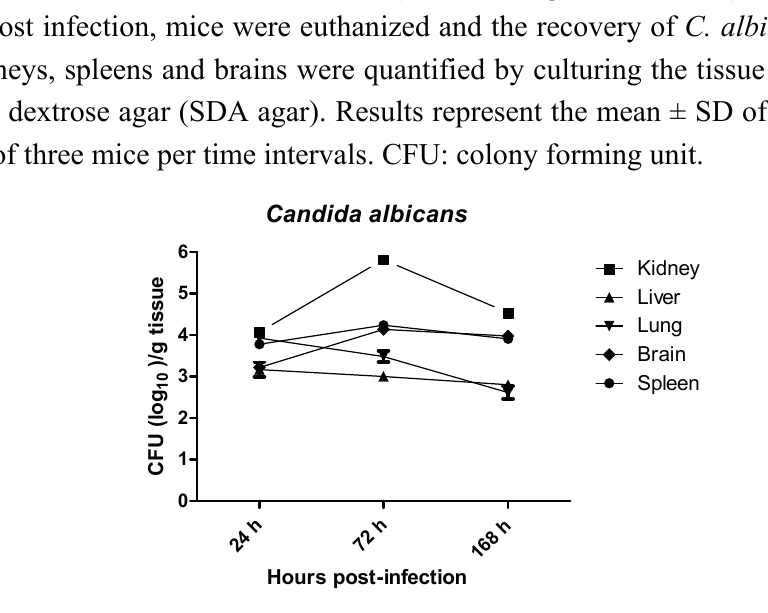
Figure 1. Growth of C. albicans in tissues of immuncompetent BALB/C female mice.